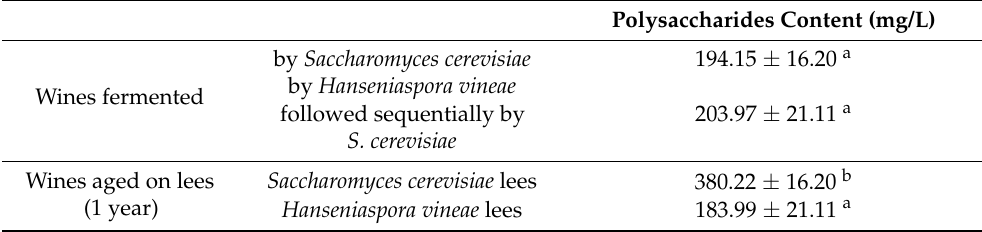
Figure 3. Molecular exclusion Liquid Chromatography-Refractive Index Detection (LC-RID) chromatograms of cell wall polysaccharides in 120 L triplicate fermentations of S. cerevisiae and H. vineae ( a ). After one year of ageing on lees ( b ). Table 3. Polysaccharides (mg/L) measured by HPLC-RI. Means ± standard deviation of three replicates. Values with the same letter are not significantly different ( p <